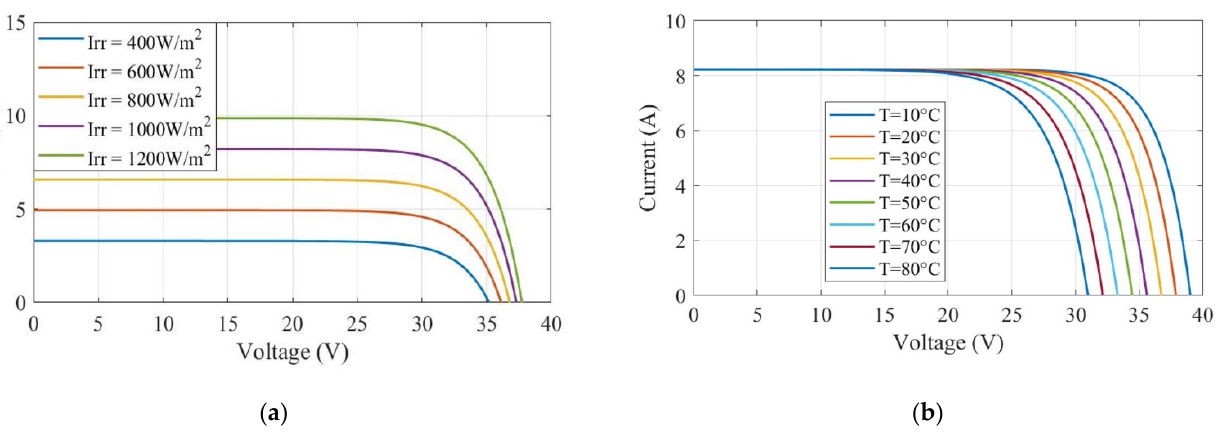
Figure 1. Voltage–Current curves of the photovoltaic panel; ( a ) curves obtained with fixed temperature (25 °C) as the irradiance varies, ( b ) curves obtained with fixed irradiance (1000 W/m 2 ) as the temperature varies.